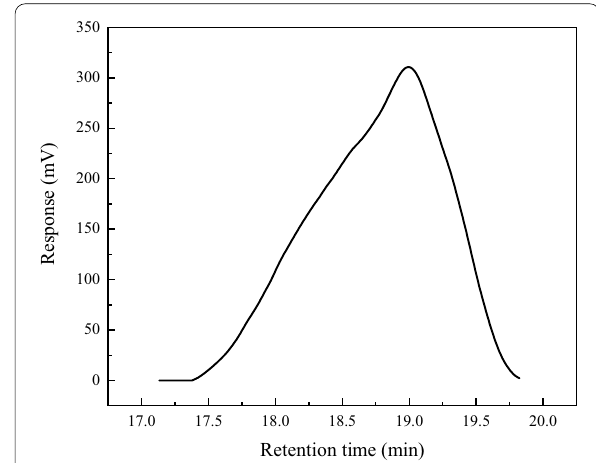
Fig. 9 Molecular weight distribution of the palm fiber lignin